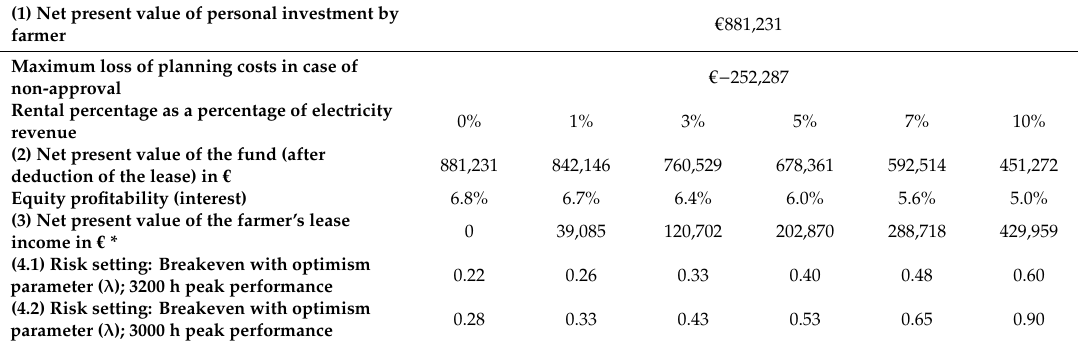
Table 3. Net present value of the investment of a wind turbine with 3200h peak performance in the case of personal investment by a farmer (1) or an external investor (2) and the net present value of the leasing revenue (3) depending on the rent share of the electricity revenue after taxes and